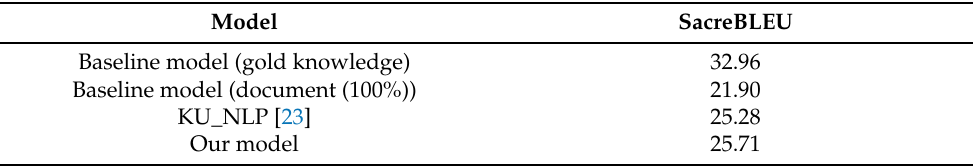
Table 5. Performance comparison with state-of-the-art models on the Doc2dial dataset. Model